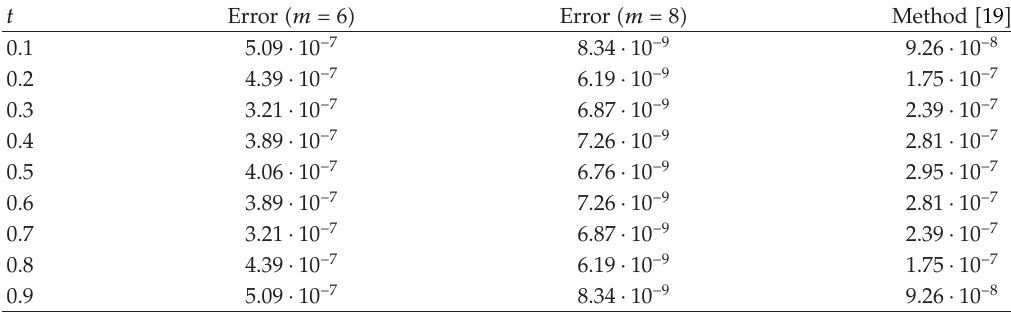
Table 8: Problem (cid:4) 5.10 (cid:5) —Example 5.8, λ (cid:6) 1.